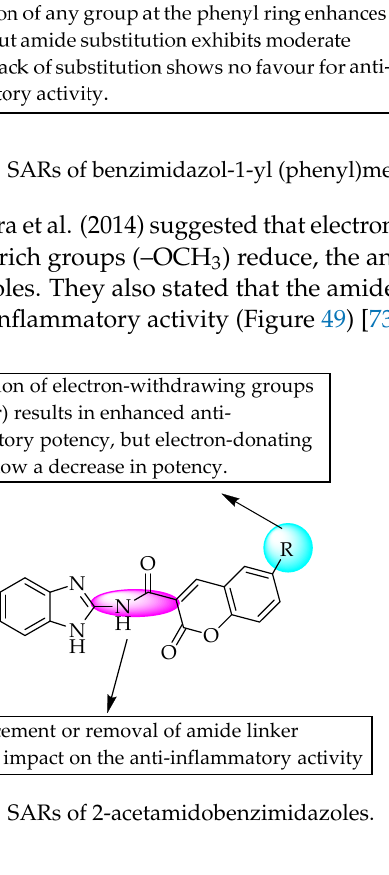
Figure 49. SARs of 2-acetamidobenzimidazoles.